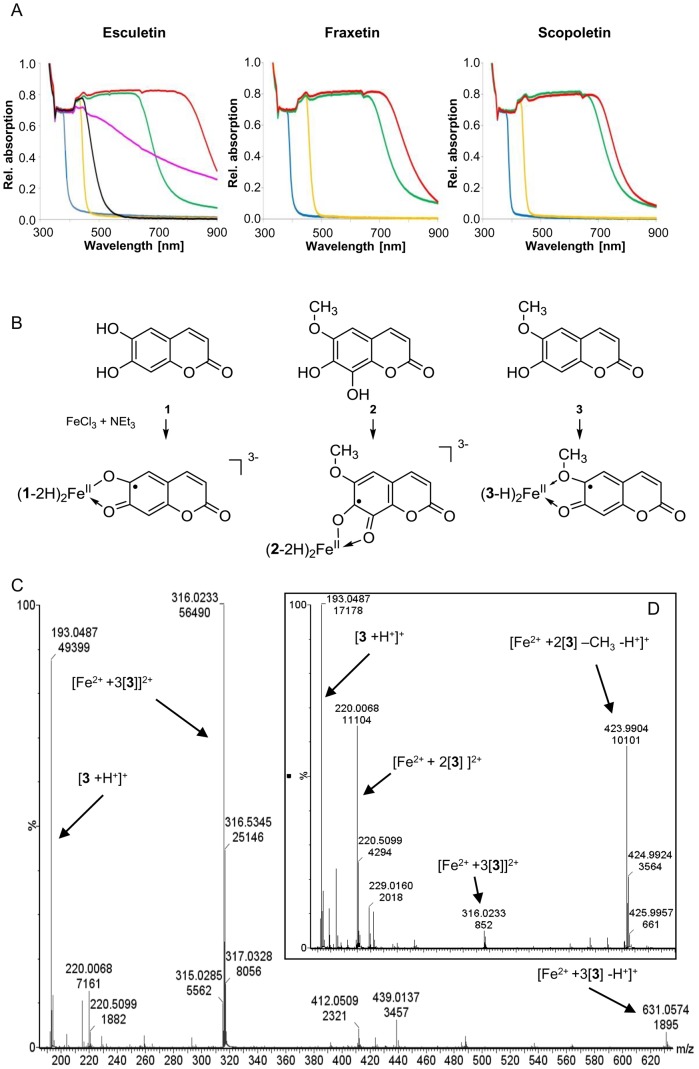
UV/vis spectroscopy and direct-infusion ESI-QTOF-MS demonstrate reduction of Fe(III) by coumarins and the formation of Fe(II)-coumarin complexes in vitro.(A) Optical spectra of solutions (CH3CN) of ligands esculetin (1), fraxetin (2) and scopoletin (3), of iron salts, of mixtures of ligands and 2 equiv of NEt3, and of mixtures containing 3 equiv of ligand, 6 equiv of NEt3, and 1 equiv of FeCl2 or FeCl3. Left: 1 (blue); 1+ NEt3 (orange); 1+ NEt3+ FeCl2 (green); 1+ NEt3+ FeCl3 (red); FeCl3 (black); FeCl2 (magenta). Center: 2 (blue); 2+ NEt3 (orange); 2+ NEt3+ FeCl2 (green); 2+ NEt3+ FeCl3 (red). Right: 3 (blue); 3+ NEt3 (orange); 3+ NEt3+ FeCl2 (green); 3+ NEt3+ FeCl3 (red). (B) Interpretation of the UV/vis spectra depicted in (A). (C) Results of direct-infusion ESI-QTOF-MS of a mixture of Fe(II) with synthesized and purified scopoletin. (D) MS-MS spectrum of the main signal at m/z 316.02.